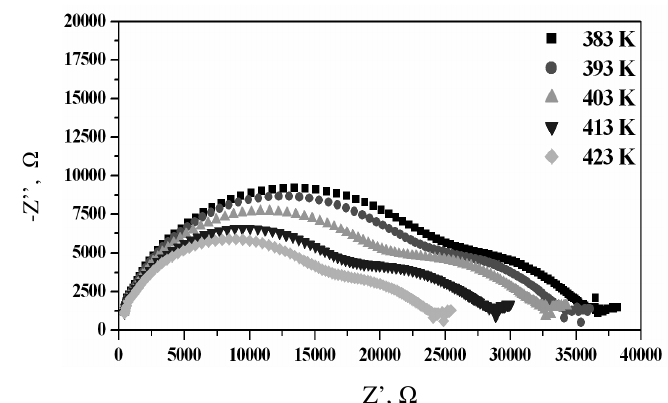
H N ]ZnCl at rising temperature 9 22 2 4